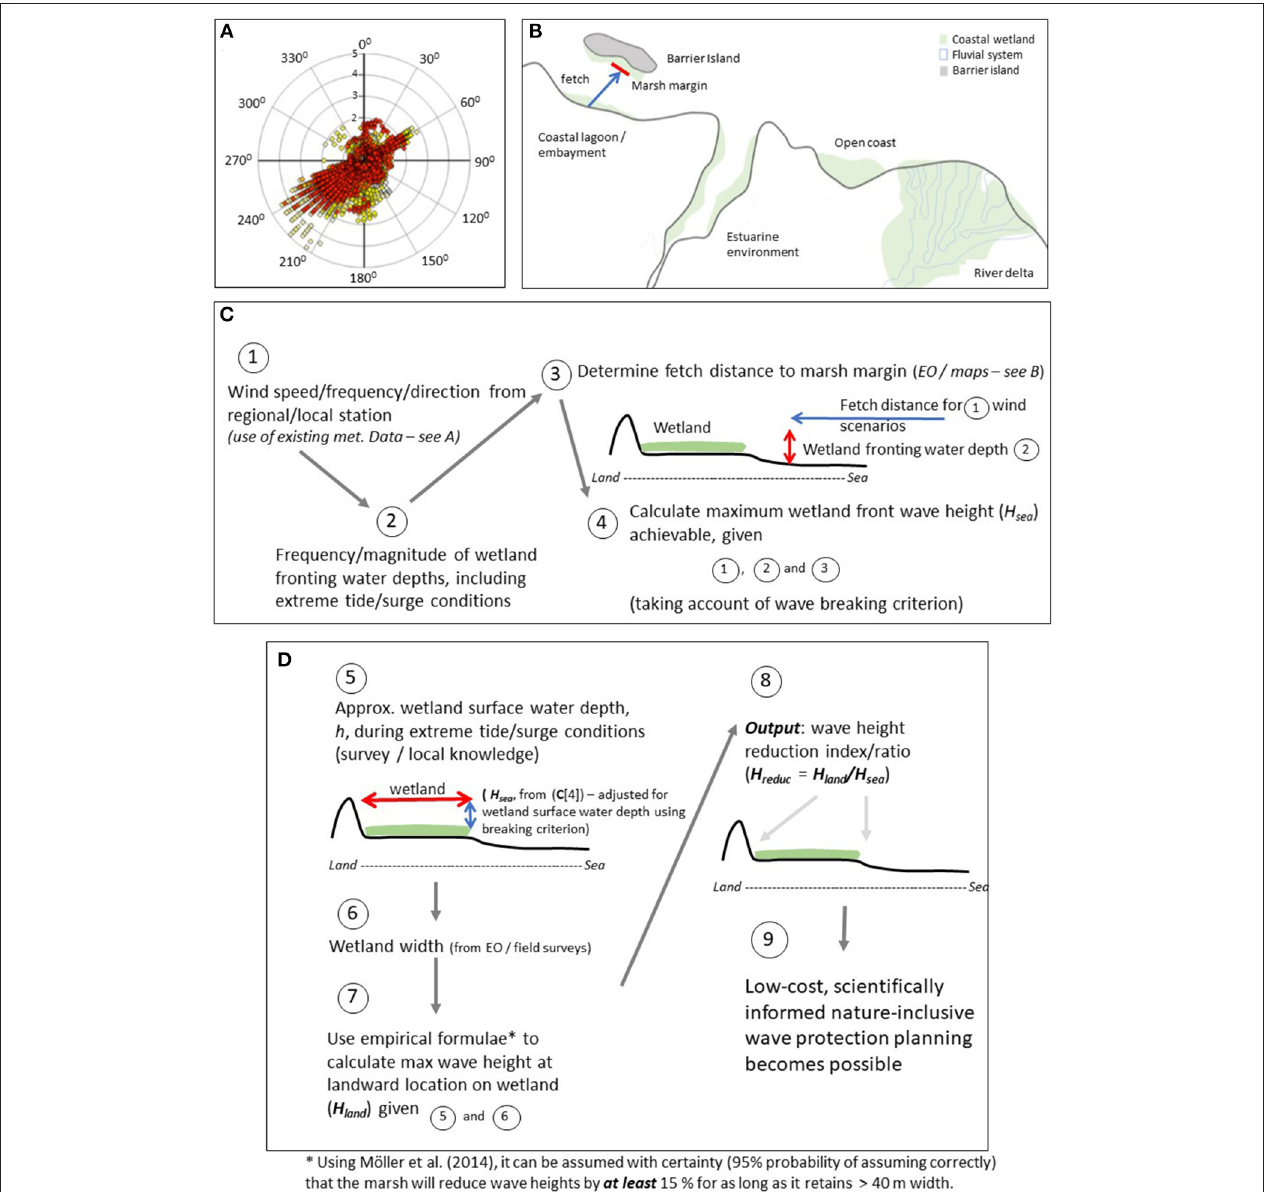
FIGURE 1 | Steps by which wave height at the seaward and landward limit of the wetland can be compared. Wind speed and direction [ A,C (1)] in any particular coastal setting (B) combine with water depth at the front of the wetland [ C (2)] and the fetch distance over which the wind blows [ C (3)] to generate maximum wave heights achievable at the wetland front [ C (4)]. In (D) wetland surface elevation and wave breaking limit maximum water depths and wave heights, respectively, at the seaward wetland margin (5); wetland width (6) and empirical formulae (7) allow an estimate of maximum wave heights at a distance > 40m inland of the wetland margin (8). Red line and blue arrow in (B) illustrate location of wetland margin and fetch distance for a specific fetch-limited marsh setting; in other settings, waves may be depth- rather than fetch-limited (open coast) or onshore winds may be rare/weak (any north-west exposed shore in the given